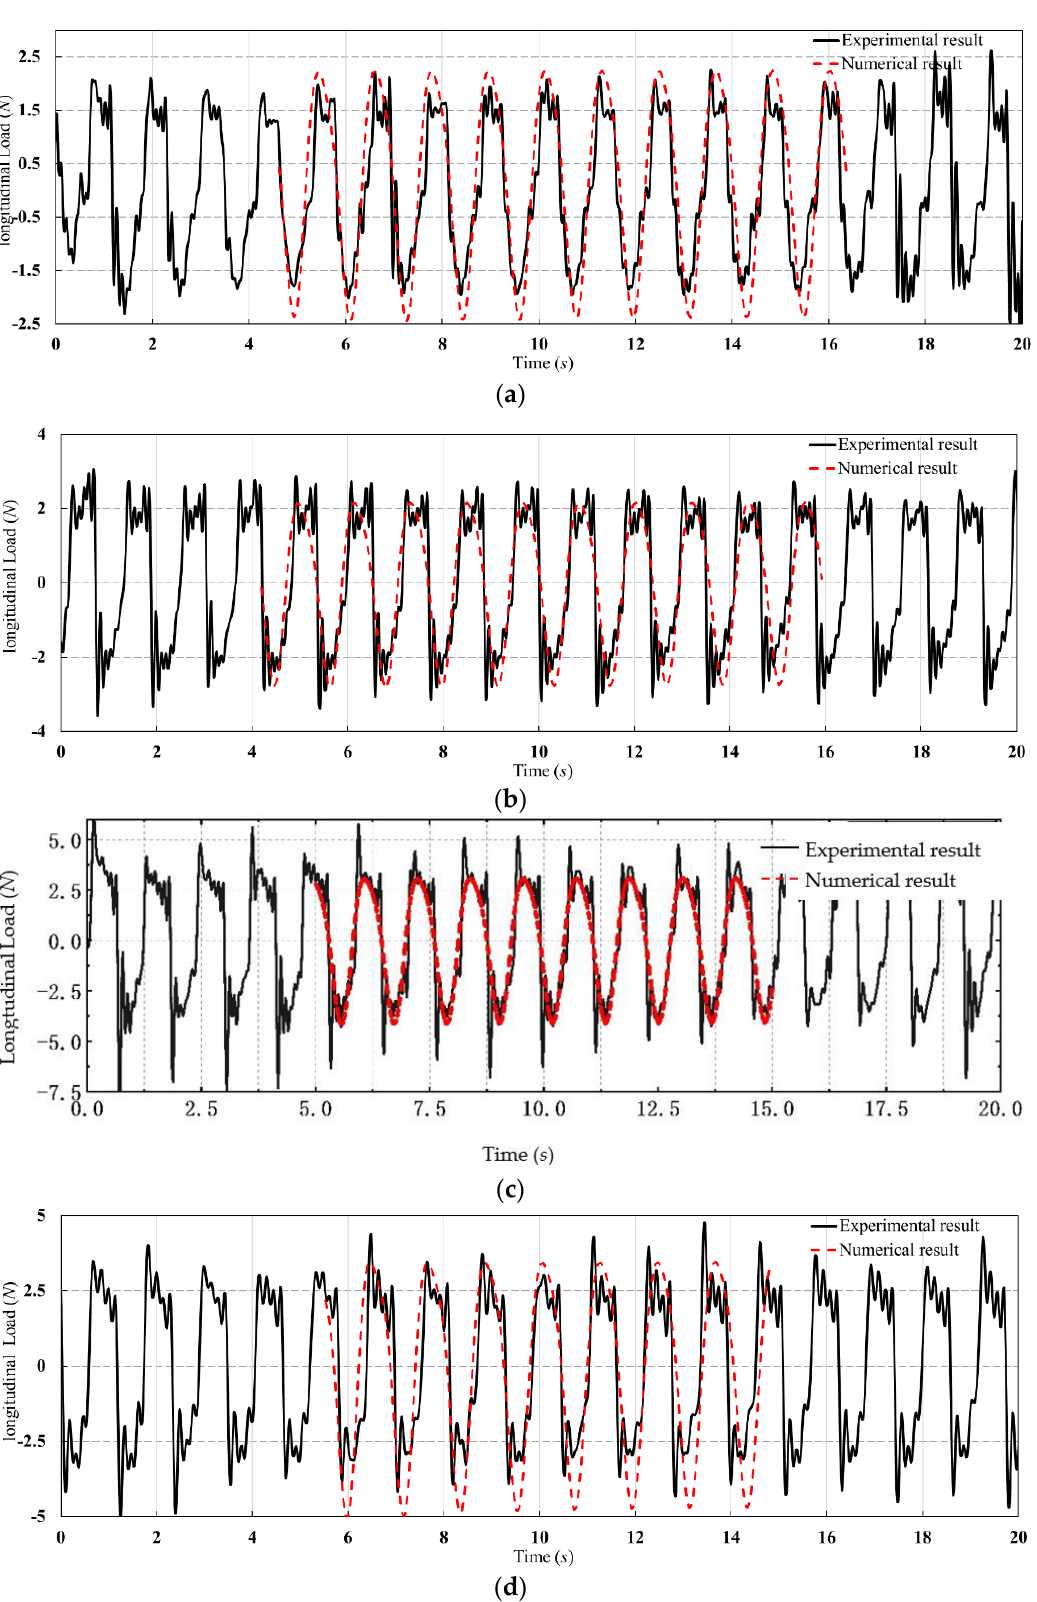
Figure 9. The longitudinal load time history in conditions height − 1~height − 4: ( a ) height − 1; ( b ) height − 2; ( c ) height − 3; ( d ) height − 4.